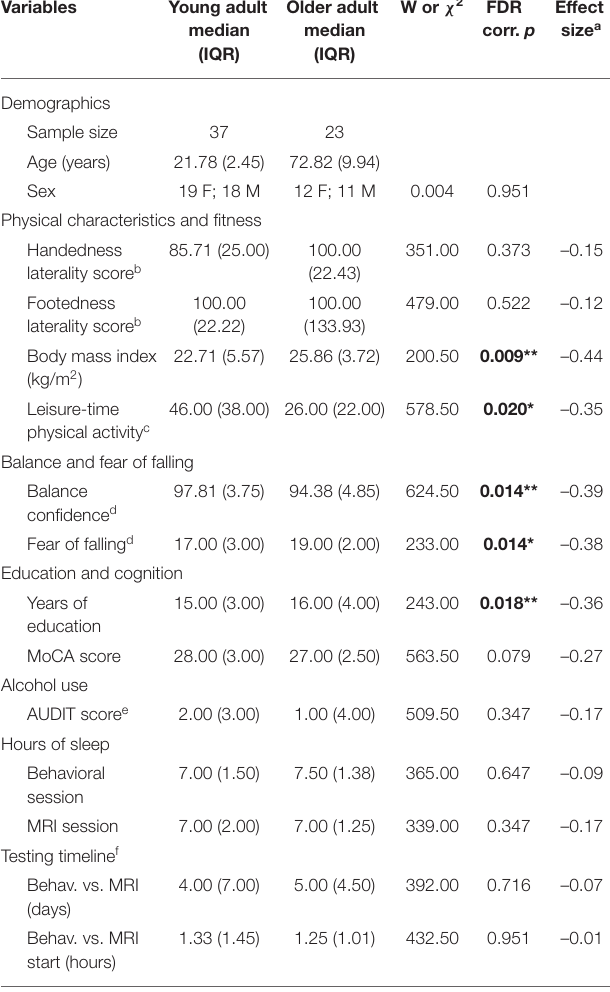
TABLE 1 | Participant characteristics and testing